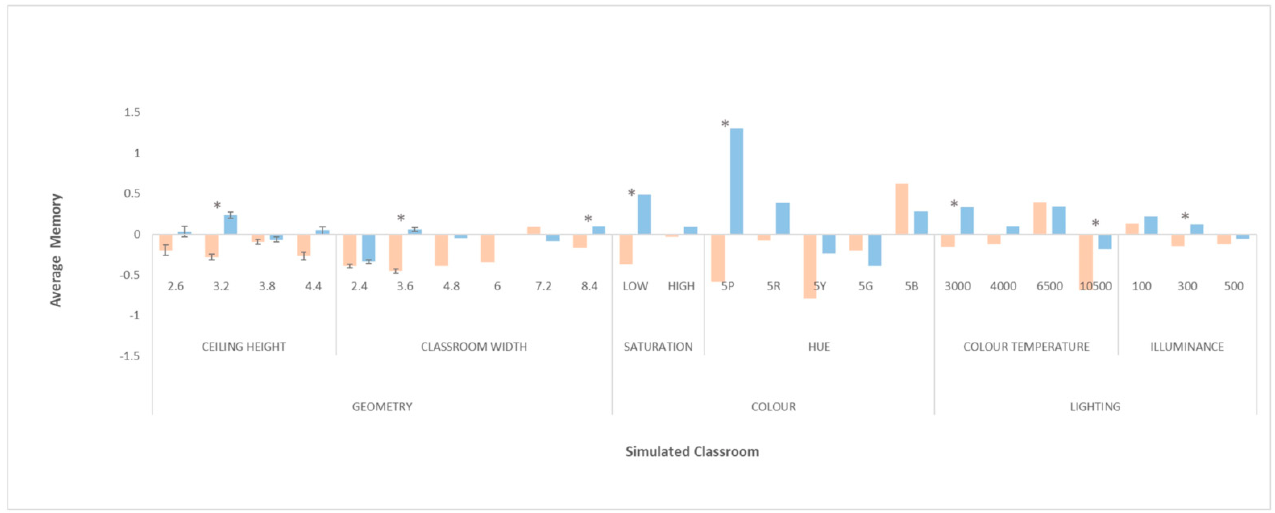
Figure 8. Normalised means of the psychological memory task. Memory-Correct Answers for men are shown in blue; and for women shown in orange. An asterisk marks the significant differences between genders.